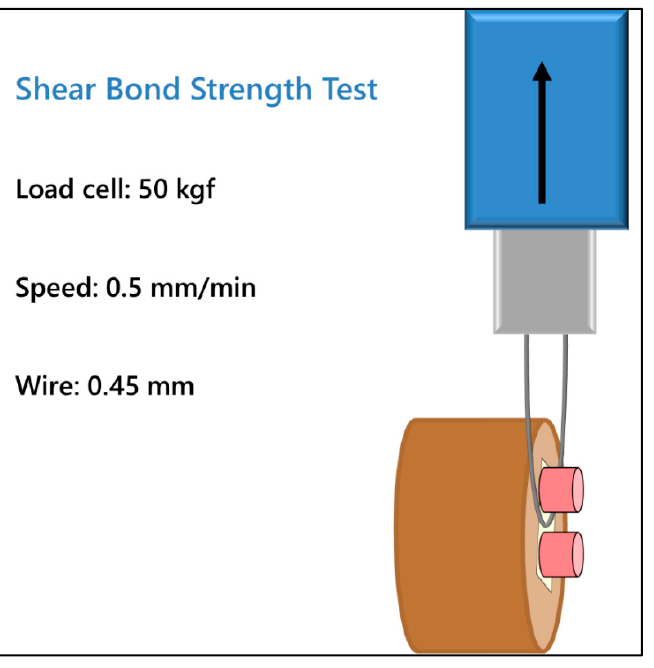
Figure 3. Schematic representation of the SBS test. Set prepared for the test in which was employed an orthodontic-looped wire to stress the bonding interface at the universal testing machine (EMIC).